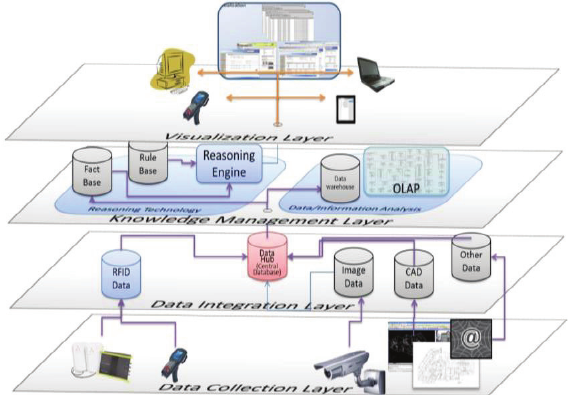
Fig. 1. Proposed Knowledge Hub Structure 6,